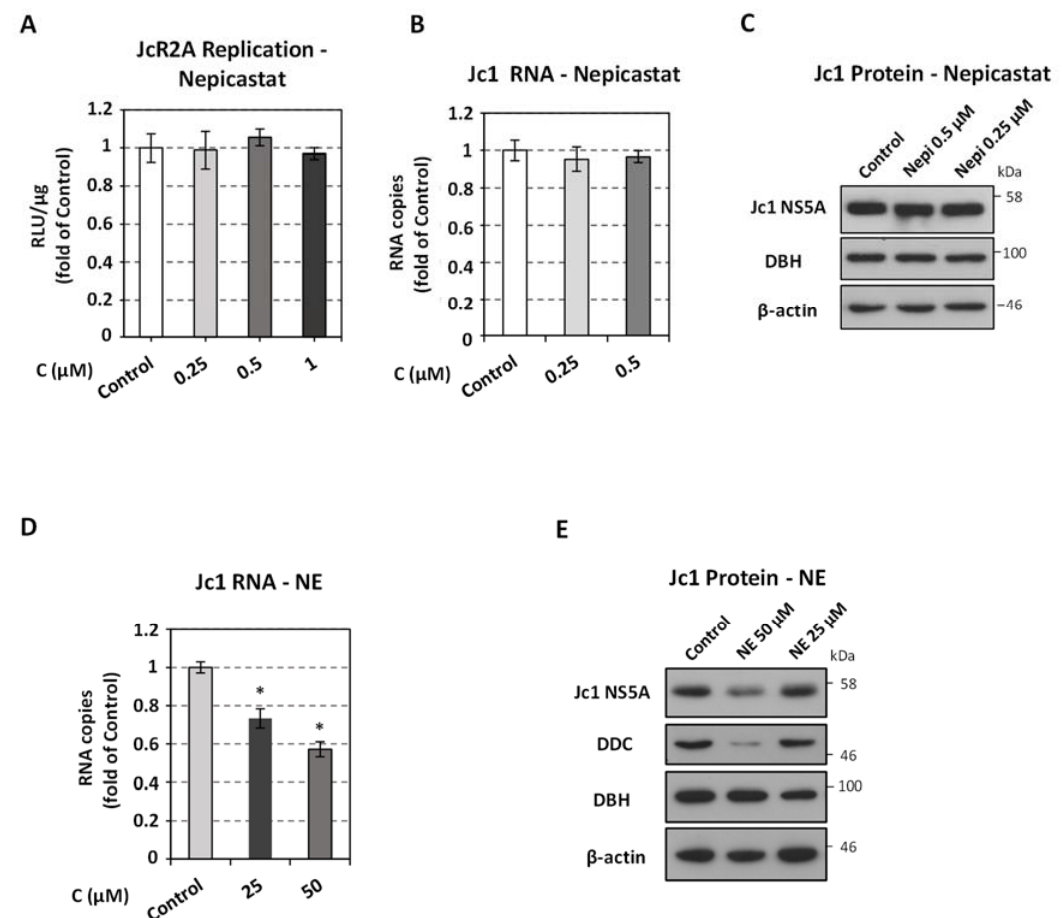
Figure 4. Effect of DBH inhibitor nepicastat and DBH product NE on HCV replication. ( A – C ) Huh7.5 cells were inoculated with JcR2A (MOI = 0.5) ( A ) or Jc1 (MOI = 1) ( B – E ) for 4 h and subsequently treated or not (Control) for 72 h with different concentrations of nepicastat ( A – C ) or NE ( D , E ), or were mock treated (Control). ( A ) Virus replication-derived R-Luc activity was determined in cells cultured in the presence or absence of nepicastat and expressed as RLU/ µ g of total protein amount. ( B , D ) Jc1 positive-strand RNA levels, in cells treated with nepicastat ( B ) or NE ( D ), or mock-treated, were quantified by RT-qPCR and YWHAZ mRNA was used for normalization. ( A , B , D ) Values from infected non-treated cells were set to one. Bars represent mean values from three independent experiments in triplicate. Error bars indicate standard deviations. * p < 0.01 vs. Control. ( C , E ) Western blot analysis was performed in lysates of Jc1-infected cells treated for 72 h with nepicastat ( C ), or NE ( E ) or mock-treated (Control) using anti-HCV NS5A, anti-DBH, anti-DDC or anti- β -actin antibodies. β‐ actin was used as loading control. A representative experiment of three independent repetitions is shown.